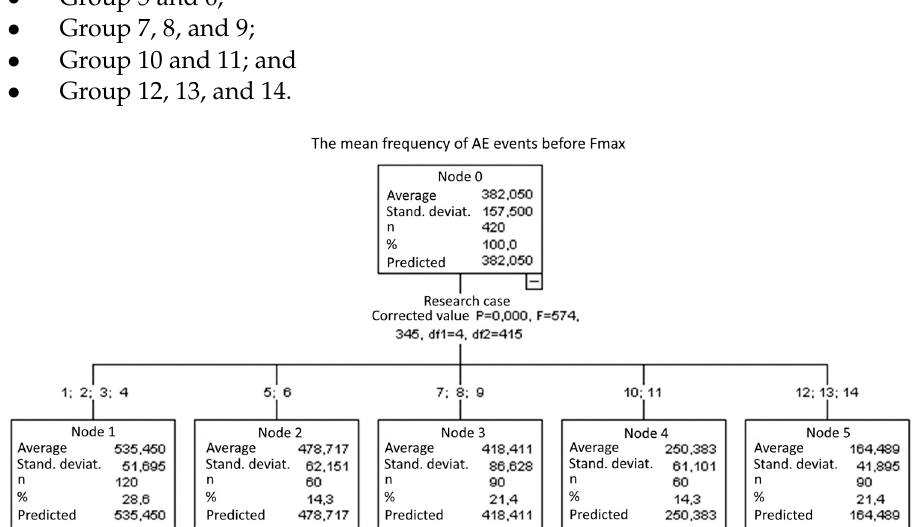
Figure 18. Classification tree for the average frequency of AE events before reaching F max .